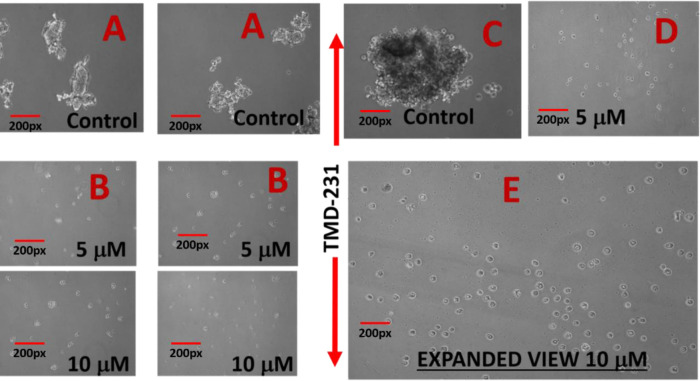
Treatment of CSC enriched cells with AMP-001 negatively affects cancer stem cell activity and reduces mammosphers (precursor for self-renewal of CSCs) compared to control in vitro.Mammospheres were measured by microscopy following treatment with AMP-001 in two different CSC enriched cell lines, MCF-10A-ER-SRc and TMD-231, n = 4 experiments, p< 0. 04, SD = 7.8, A & C: Untreated Controls (3 Views, Same Scale).